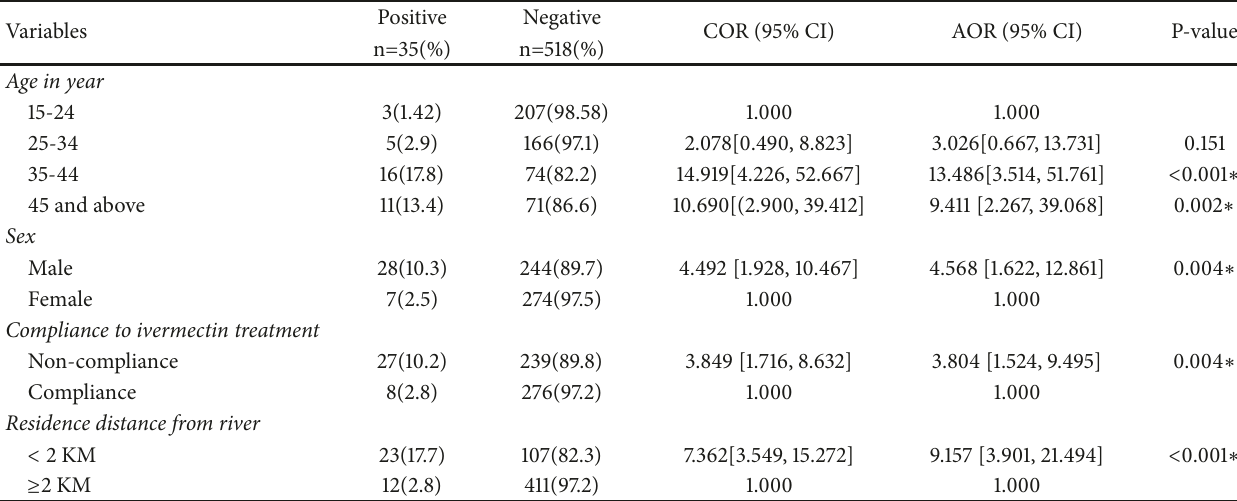
Table 5: Independent predictors of onchocerciasis infection in Semen Bench district, Bench Maji Zone, Southwest Ethiopia, June